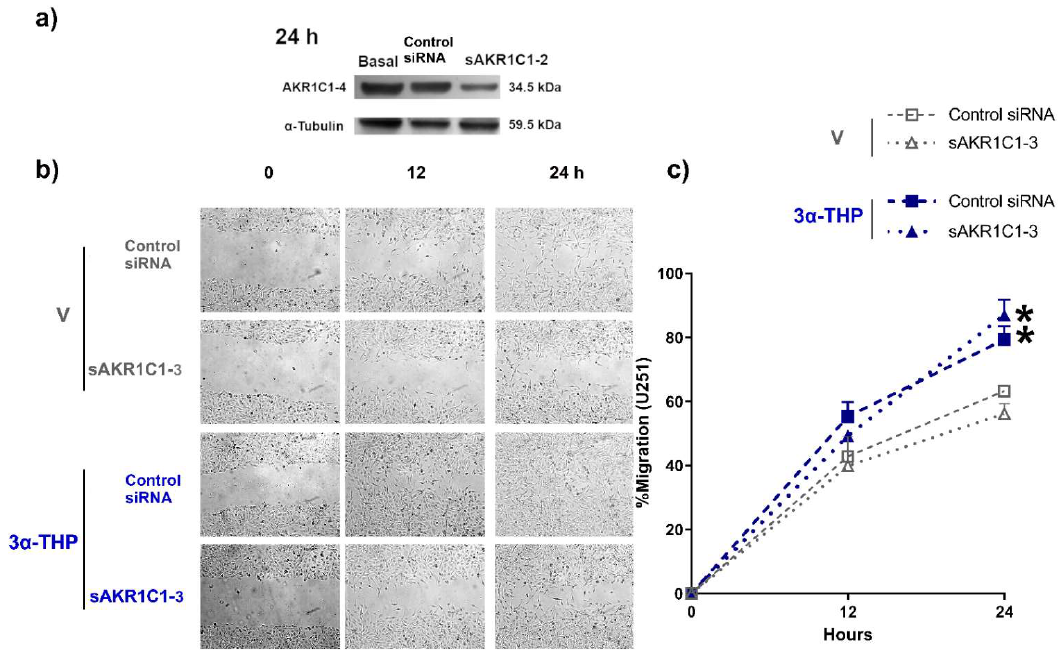
Figure 4. Effect of 3 α -THP and the silencing of AKR1Cs on the migration of U251 cells. ( a ) AKR1C1-3 silencing for 24 h and at the beginning of migration assays. ( b ) Representative images of U251 cells without transfection, transfected with the negative control siRNA (Control siRNA), and transfected with de the siRNA against AKR1C1-3 (sAKR1C1-3). Cells were treated with V or 3 α -THP. ( c ) Graph of the percentage of U251 migrating cells. Each point represents the mean ± SEM. * p < 0.05 3 α -THP (control siRNA, and sAKR1C1-3) vs. V (control siRNA, and sAKR1C1-3); n = 3. Next, we determined the effect of 3 α -THP metabolism on the human GB U251 cell line invasion. 3 α -THP promoted the invasion of the U251 cell line in Control siRNA, and sAKR1C1-3 groups when compared with V (Control siRNA and sAKR1C1-3). We did not find any significant differences in cell invasion between groups treated with V (Control siRNA and sAKR1C1-3), nor between those treated with 3 α -THP (Control siRNA and not by generating other progestin products from AKR1C1-3 activity in GB cells.